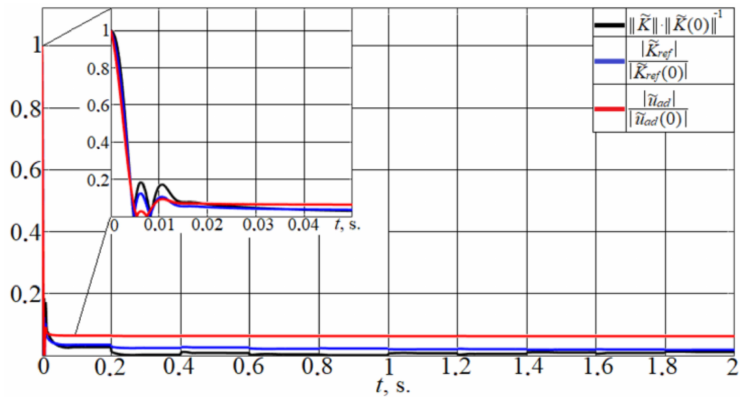
(cid:13) (cid:13) (cid:13) (cid:13) − 1 (cid:13) (cid:13) (cid:13) (cid:13) · ( 0 ) are shown (cid:13) (cid:101) K (cid:13) (cid:13) (cid:101) K (cid:13)